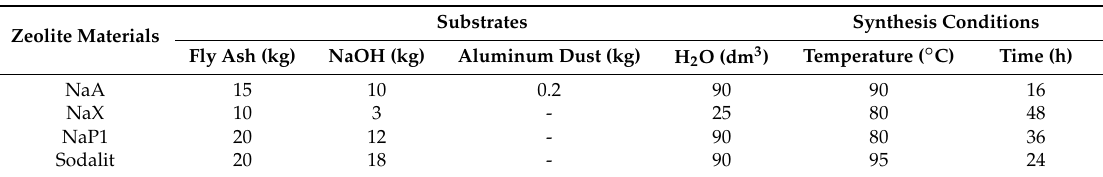
Table 2. Synthesis parameters of zeolites materials used in